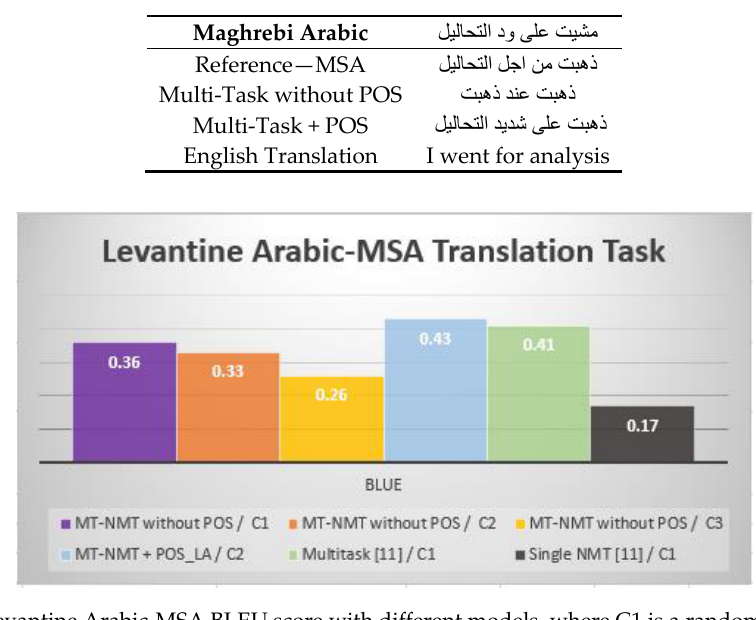
Table 6. Translation examples for Levantine.